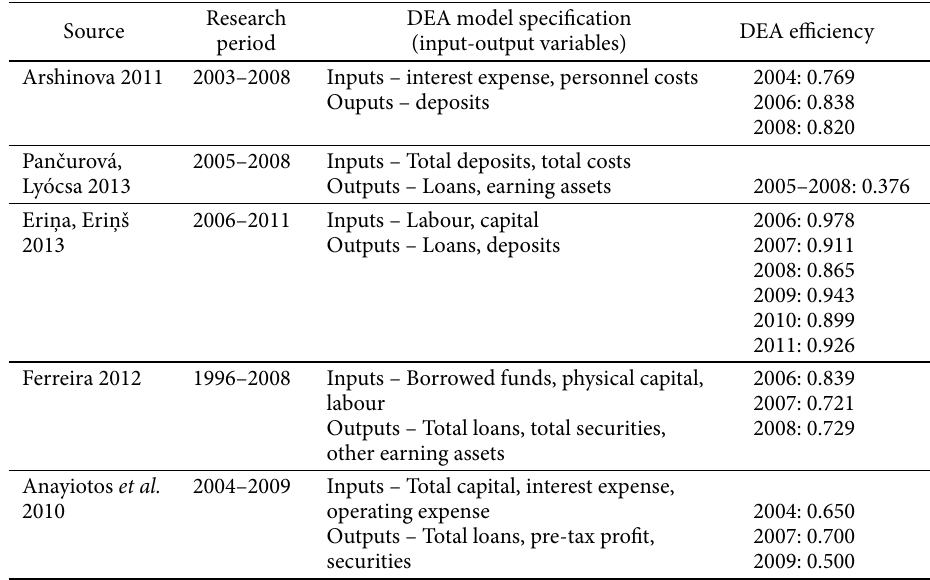
Table 1. DEA application for Latvian banking